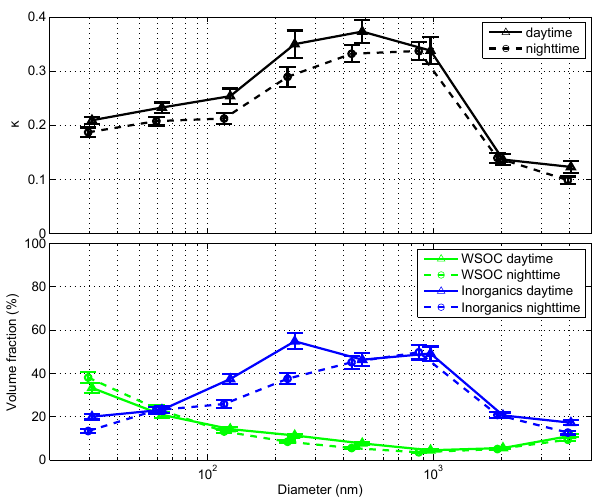
Fig. 7. The upper panel (a) shows the average κ curves with uncer- tainties derived from the daytime and the nighttime measurements, respectively. The bottom panel (b) shows the corresponding volume fractions of WSOC and overall inorganics with